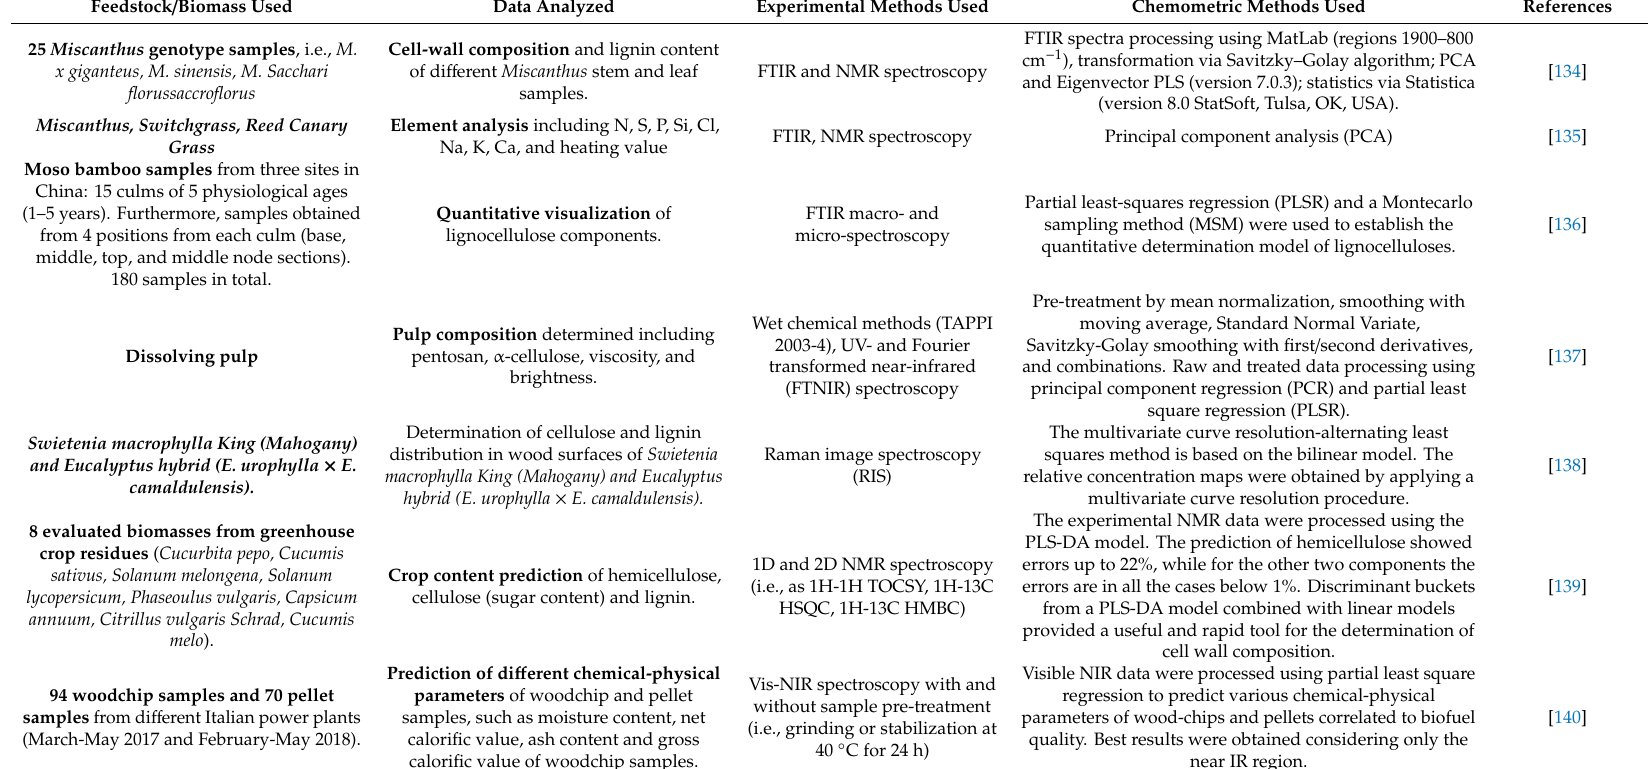
Table 3. Chemometrics in LCF composition and structure analysis